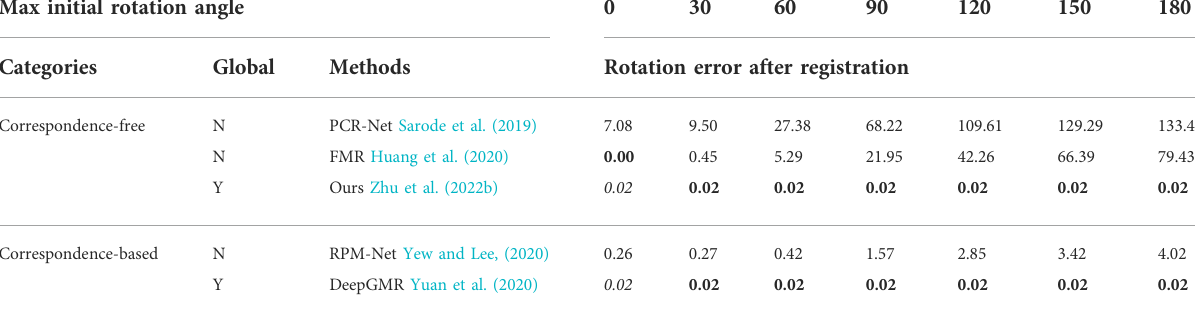
Bold values in tables show the best performance.